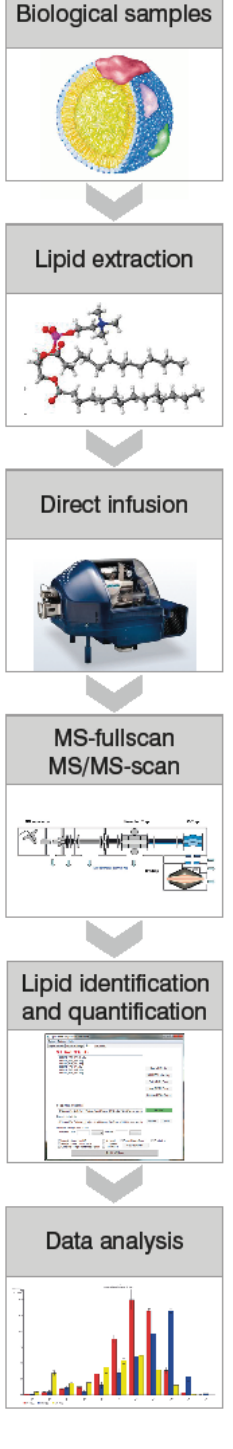
Figure 1. Schematic outline of a high throughput shotgun lipidomics platform consisting of an LTQ-Orbitrap mass spectrometer coupled to a